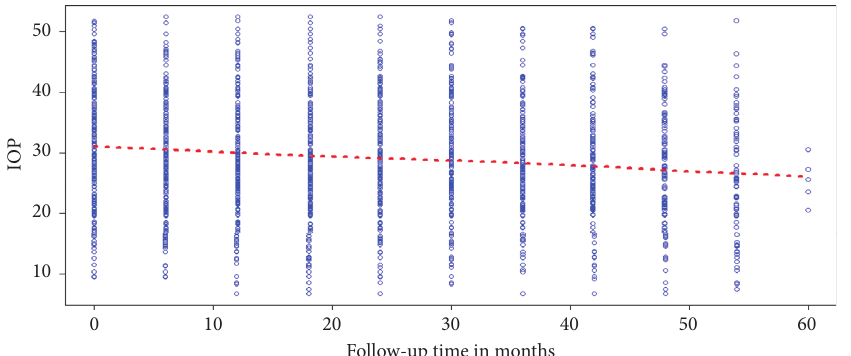
Figure 4: Loess smoothing plot with the average trend line of IOP of glaucoma